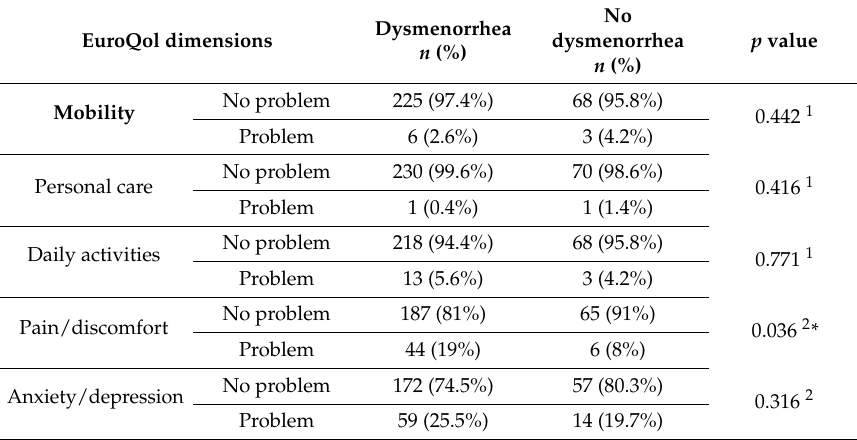
Table 2. Percentage of the sample of women with, or without, dysmenorrhea who presented problems in one of the EuroQol